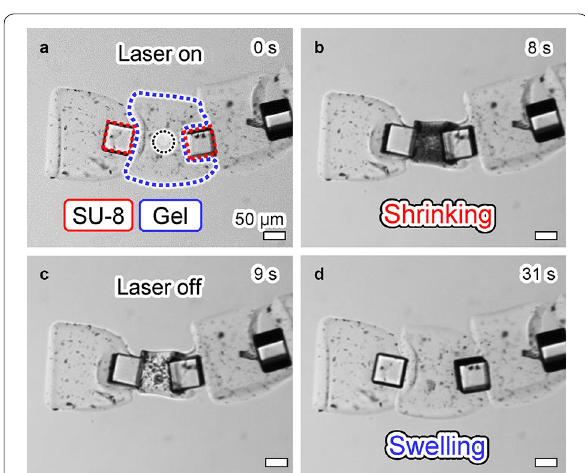
Fig. 10 Actuation of the soft microrobot. a Start of laser irradiation; b 8 s after laser irradiation begins; c laser irradiation stops; and (d) 22 s after the laser irradiation